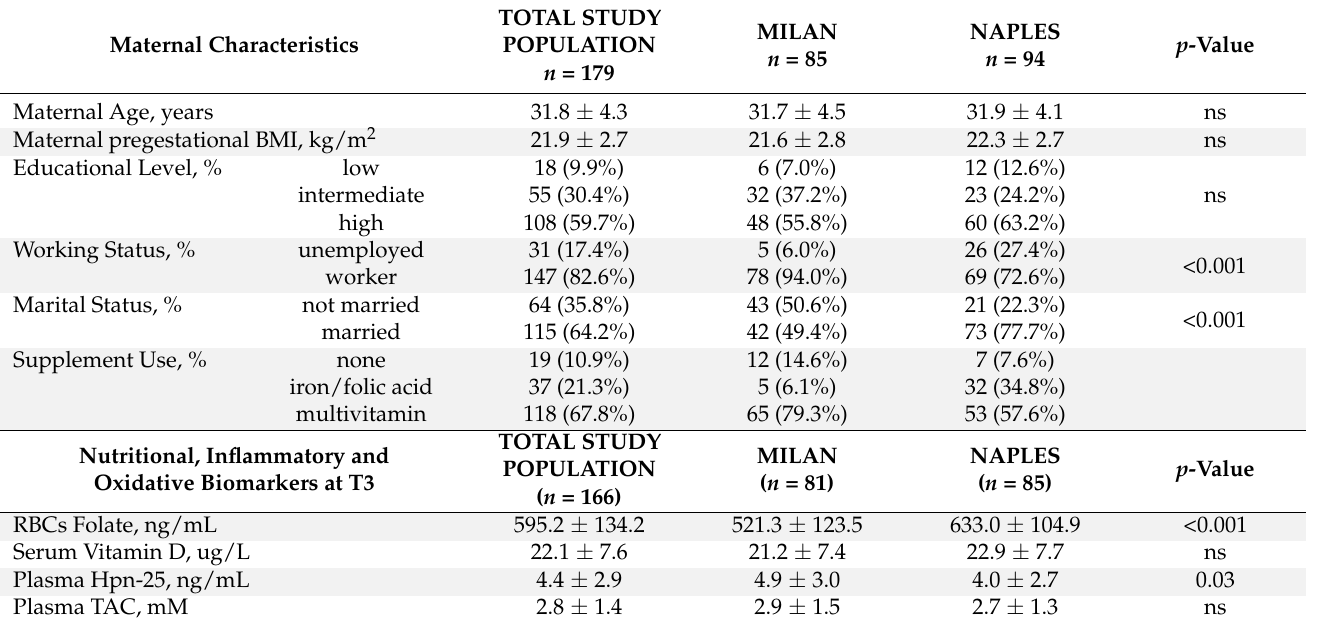
Table 1. Maternal characteristics and biomarker concentrations in the total study population and